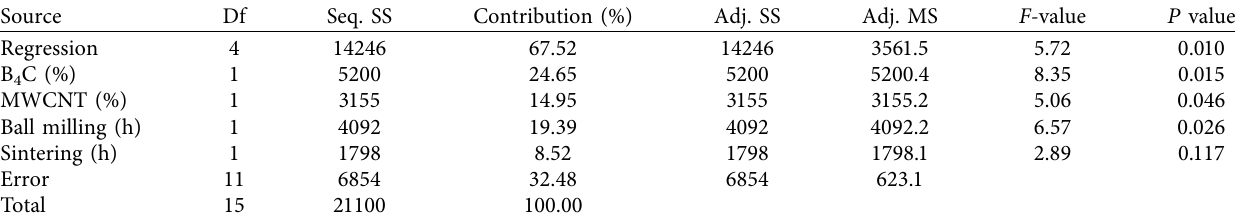
Table 9: Analysis of variance for microhardness values.